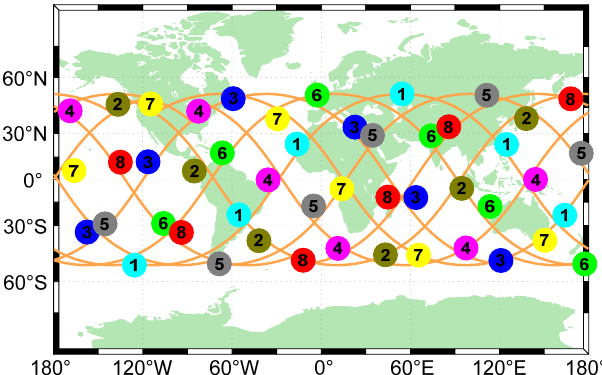
Figure 12. Graph of Globalstar grouping multiplexed PRN codes. The Globalstar constellation is a walker 52°:48/8/1 constellation with an altitude of 1414 km. Eight colors and numbers represent eight PRN codes, which are enough to realize CDMA for Globalstar constellation.